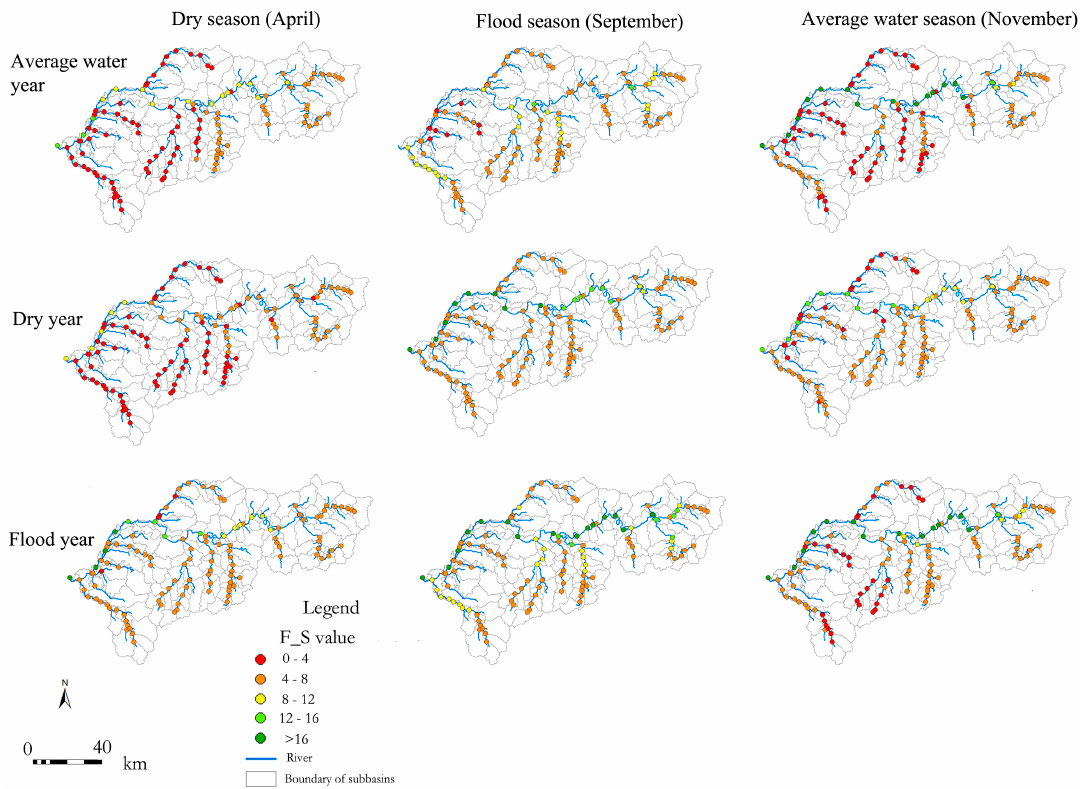
Figure 6. Temporal-spatial distribution dynamics of Fish Species Richness (F_S). Int. J. Environ. Res. Public Health 2018 , 15 , x